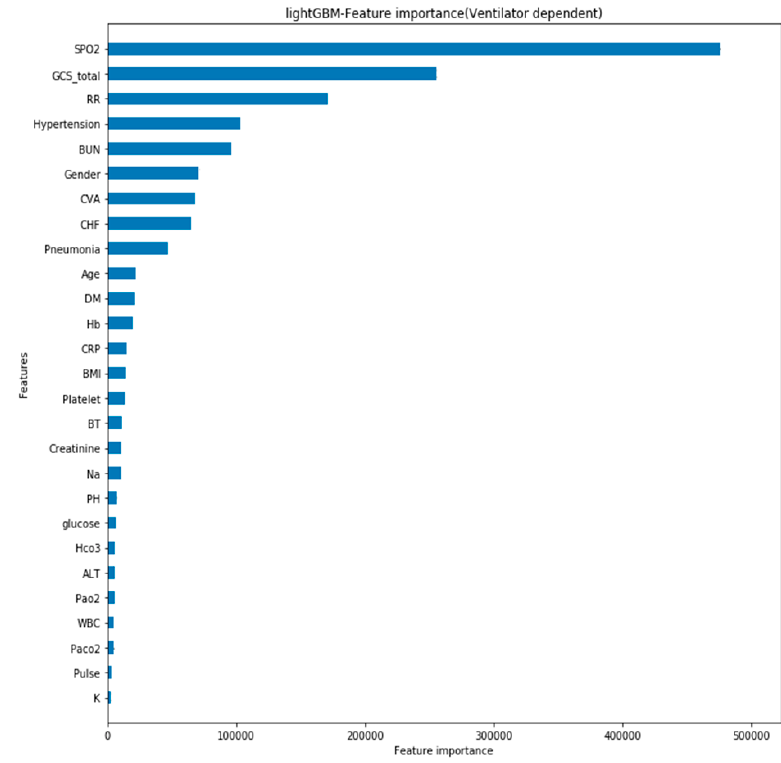
Figure 7. Feature importance of acute respiratory failure.